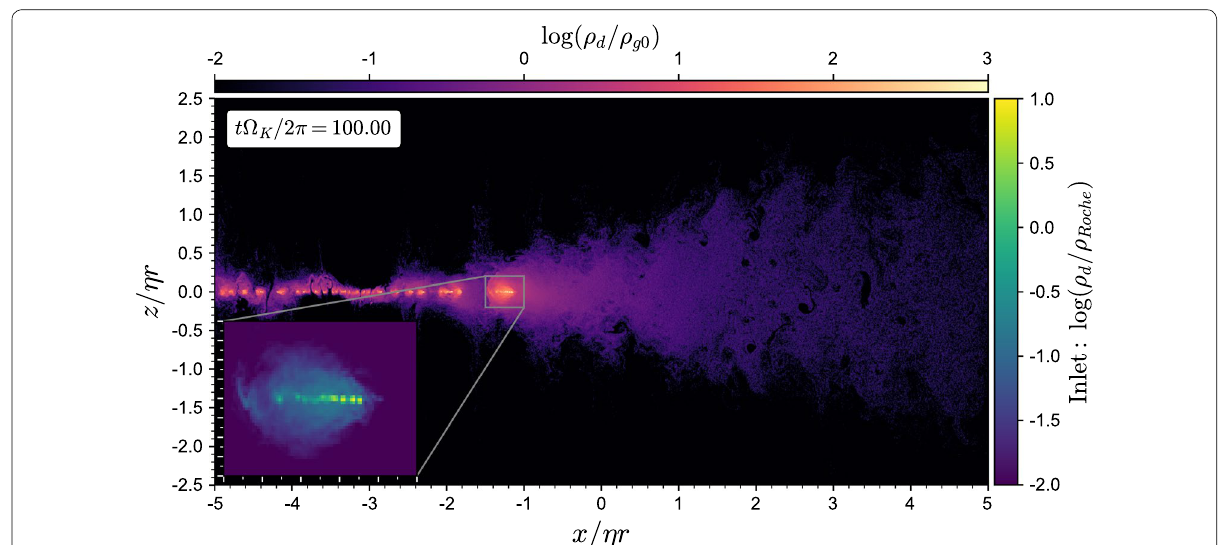
Fig. 4 Dust density distribution around x + . The dust density is normalized by ρ g 0 (the dust density shown in the inlet is normalized by ρ